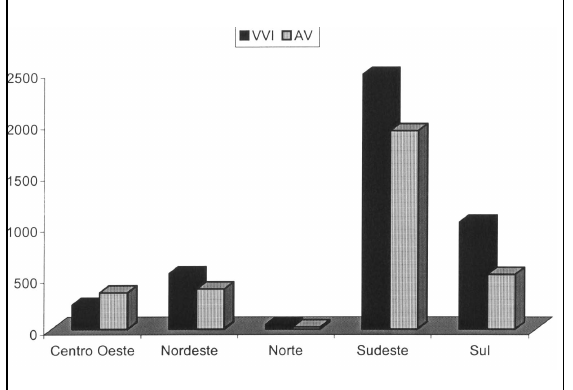
Fig. 4 - Modos de estimulação utilizados nos implantes iniciais, agrupados segundo a região brasileira onde o procedimento foi realizado.